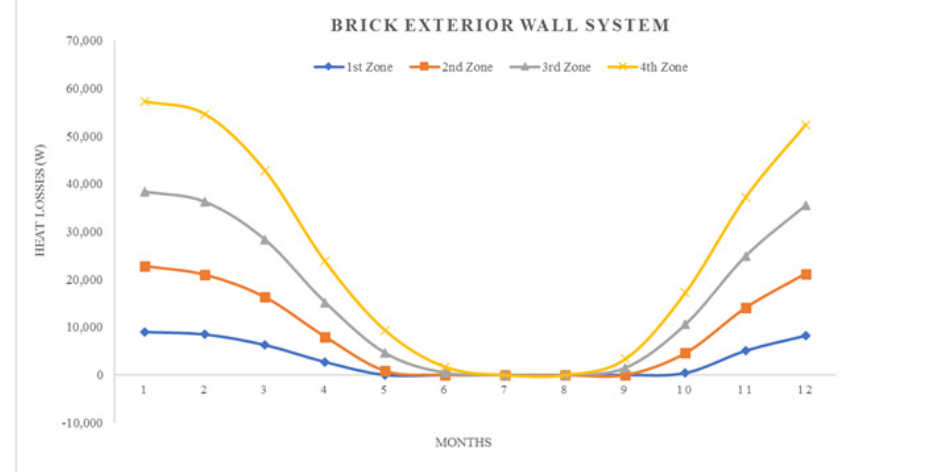
Figure 10. Heat losses for brick exterior wall system .